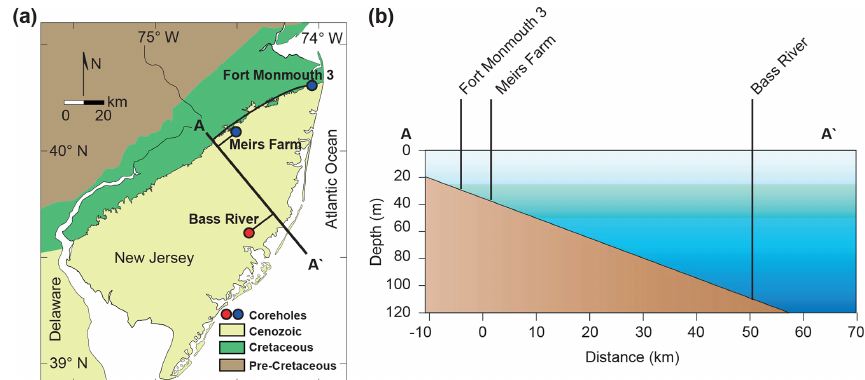
Figure 1. Geological map and paleoslope model of the New Jersey coastal plain. (a) Geological map of the New Jersey coastal plain. Bass River (Miller et al., 1998) is indicated by the red circle, and the cores drilled by the Rutgers University K–Pg boundary drilling project (Miller et al., 2010) are indicated by blue circles. (b) Paleoslope model of the New Jersey shelf showing locations of Bass River, Meirs Farm and Fort Monmouth 3, following Esmeray-Senlet et al. (2015), assuming a paleoslope of 1:750. Vertical exaggeration: 250 × .